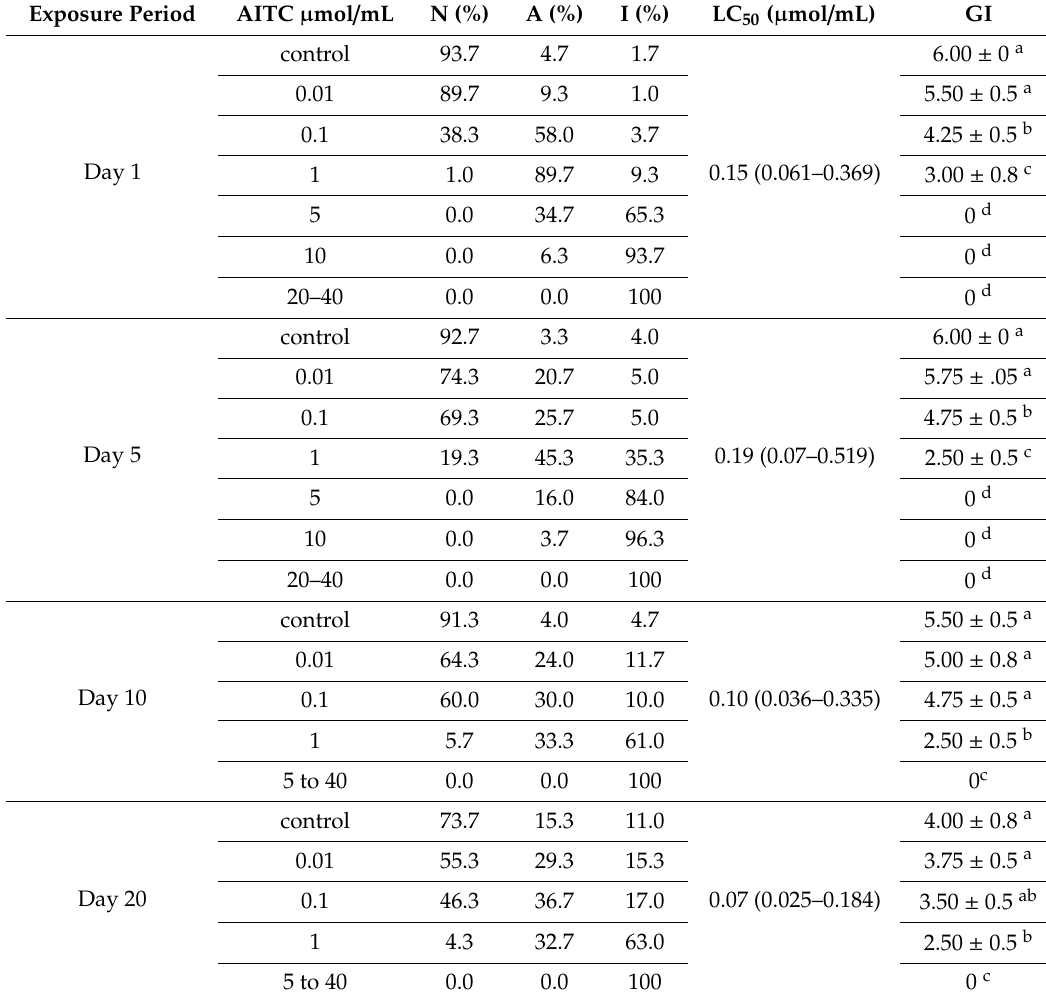
Table 3. E ff ect of allyl isothiocyanate (AITC) on Meloidogyne hapla second-stage juveniles (J2) after 1, 5, 10, and 20 days of exposure and gall index (GI) of cucumber roots three weeks after inoculation with J2 treated with the respective AITC